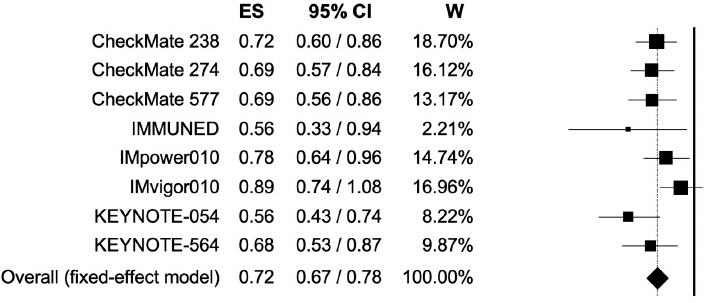
Figure 3 . Forest plot of comparison between adjuvant PD-1 and PD-L1 inhibitors versus control (placebo/ipilimumab/observation/best supportive care) in cancer patients; the outcome of interest was relapse-free survival (RFS) in the intention-to-treat population. Abbreviations: CI: confidence interval; ES: effect size; and W: weight.